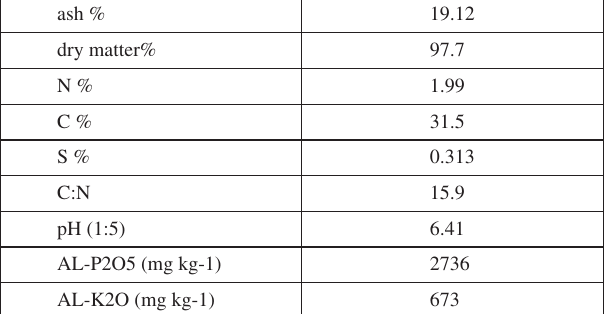
Table 3. Characteristics of the food waste compost applied to the